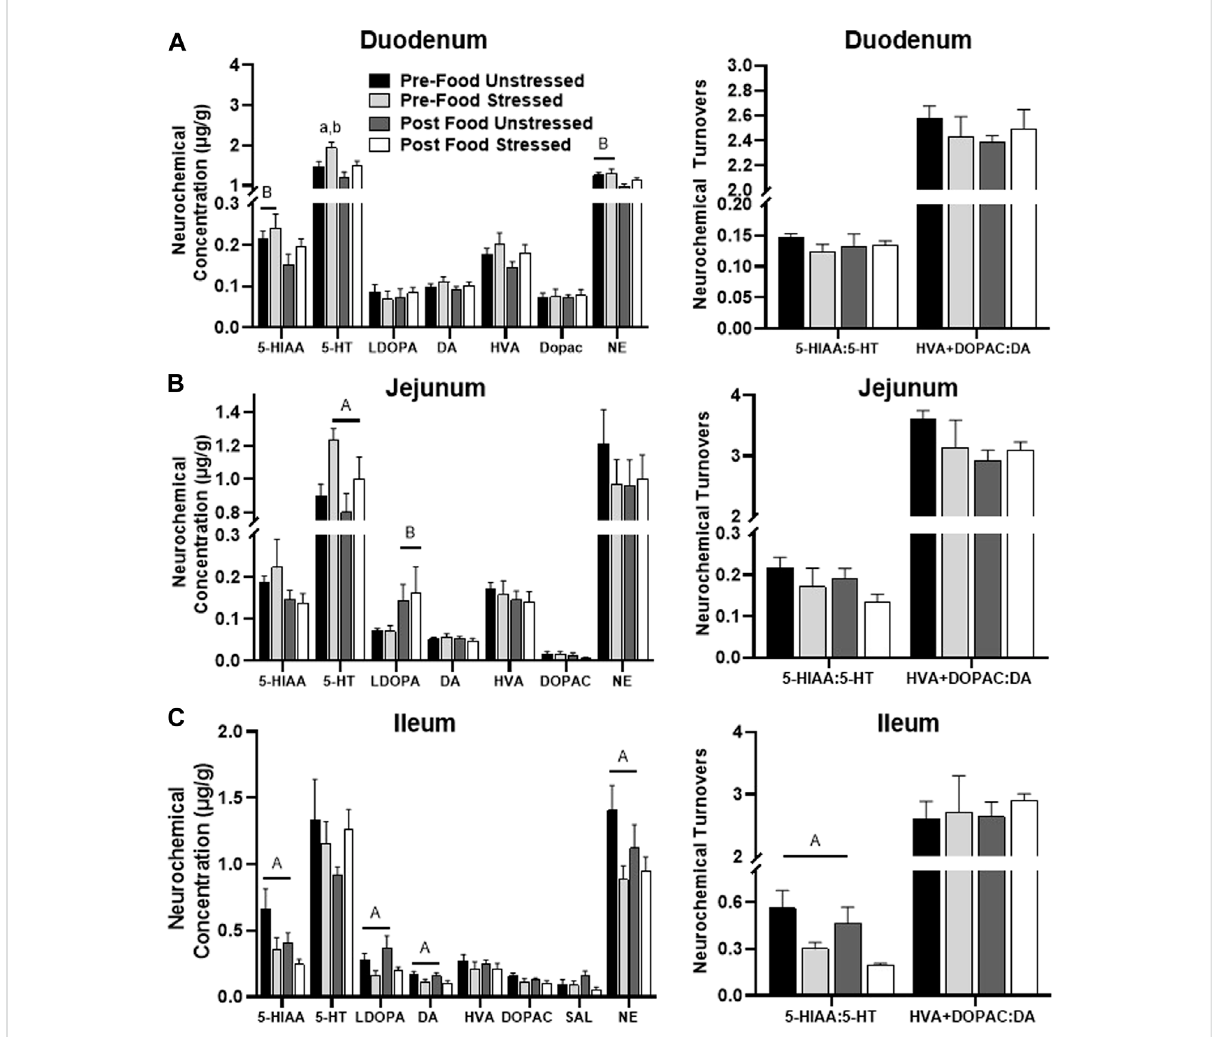
FIGURE 2 Monoamine-related neurochemical changes in the small intestines 48 h after stress exposure. (A) NE and stress-potentiated 5-HT concentrations were increased prior to food access in the duodenum. (B) Stress exposure increased 5-HT concentrations, whereas food access increased L-Dopa concentrations in the jejunum (left panel). (C) Stress lowered 5-HIAA, L-Dopa, DA, and NE concentrations (left panel), while also lowering 5-HT turnover measures (right panel) in the ileum.± S.E.M. Signi fi cant main effect of stress (A) or food access (B) from Two-Way ANOVA. (A) From Pre-Food Unstressed and (B) from Post Food Unstressed. Signi fi cance p < 0.05. Sample size n = 9 per group, except Post Food Stress group n =